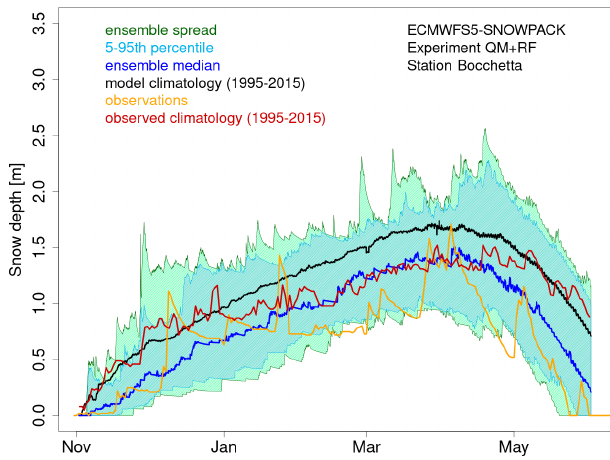
Figure 3. ECMWFS5-SNOWPACK snow depth ensemble forecasts (QM + RainFARM experiment, 250 ensemble members) initialized on 1 November 2006 and issued for the 7 months ahead, for the site of Bocchetta delle Pisse (2410ma.s.l., North Western Italian Alps). Dark green lines represent the ensemble spread, cyan lines represent the 5th–95th percentile range of the snow depth distri- bution, the blue line represents the ensemble median of the snow forecasts over the considered season, the black line represents the ensemble median of the forecasts over the reference period 1995– 2015, the orange line represents in situ observations and the red line represents the median of the observations over the reference period